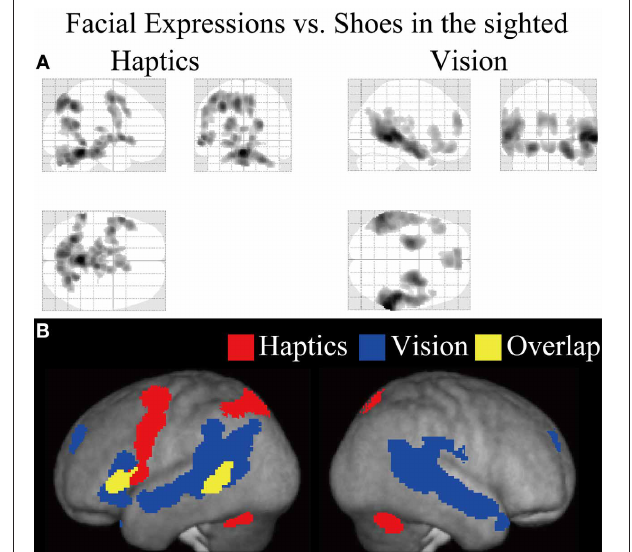
FIGURE 5 | Statistical parametric mappings (SPM) of the average neural activity within the sighted group during visual and haptic identification of facial expressions compared with shoes ( V FE − V S for vision and H FE − H S for haptics). The size of activation was thresholded at P < 0 . 05, corrected for multiple comparisons, when the height threshold was set at Z > 2 . 58. (A) The three-dimensional information was collapsed into two-dimensional sagittal, coronal, and transverse images. (B) The activation patterns during identification of facial expressions relative to shoes were superimposed on a surface-rendered T1-weighted high-resolution MRI averaged across the subjects. Regions in yellow were activated by both vision and haptics (conjunction